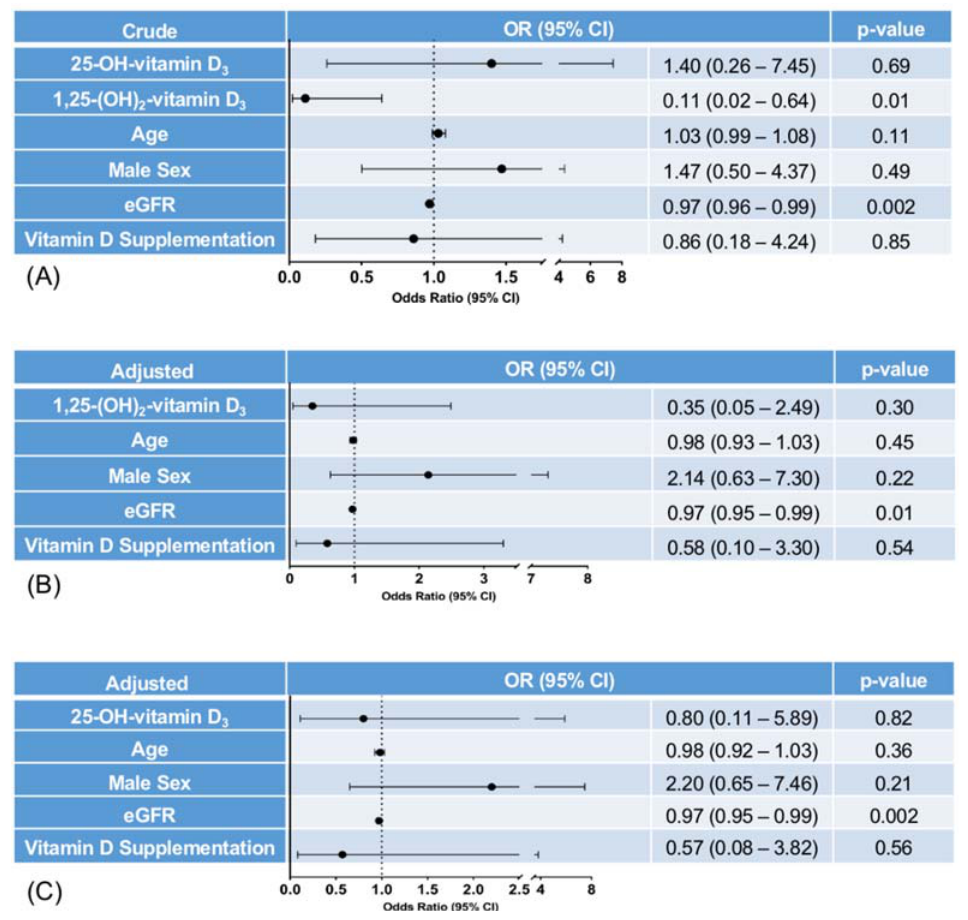
Figure 2. Logistic regression analyses assessing associations between vitamin D levels and death at one year. ( A ) In the crude model, 1,25-(OH) 2 -vitamin D 3 levels were inversely associated with death at one year, while there was no such association with 25-OH-vitamin D 3 . Likewise, a decrease in eGFR was associated with higher odds of death at one year. ( B ) After adjustment for age, male sex, eGFR, and vitamin D supplementation, there was no significant association between 1,25-(OH) 2 -vitamin D 3 levels and death at one year anymore. ( C ) Likewise, 25-OH-vitamin D 3 levels were not associated with death at one year after adjustment for covariates.